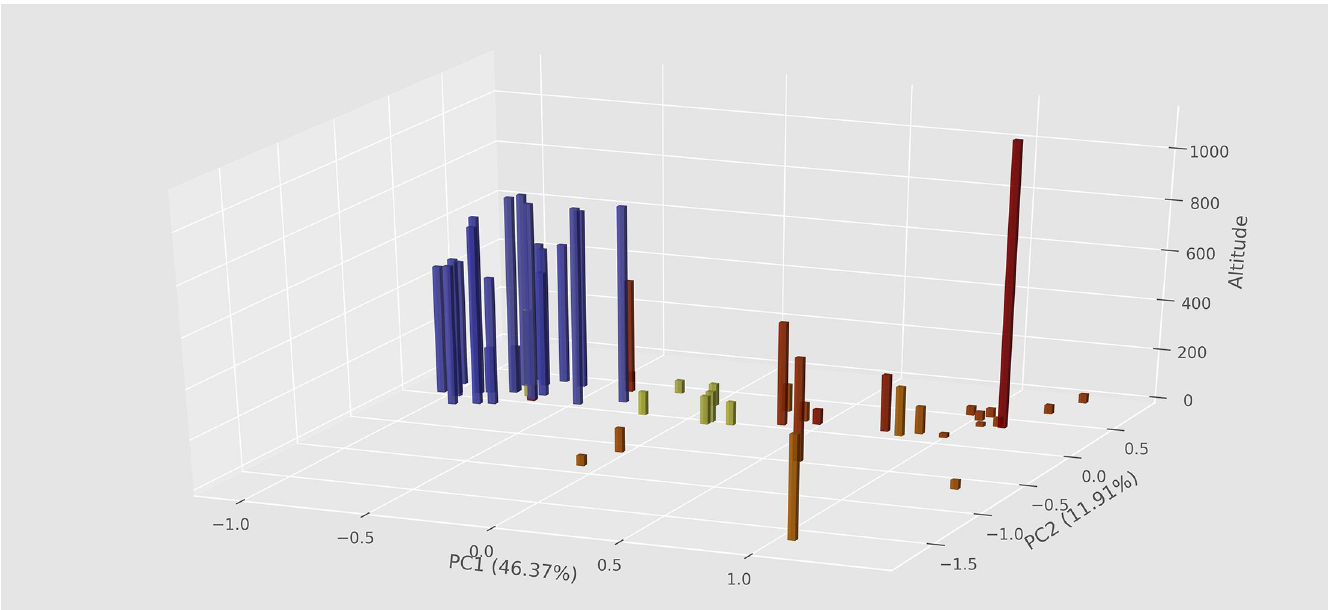
Fig 7. PCA of 27 RGB values (= 81 variables) extracted from all available females (51 specimens) of C . metamorphus sp. nov., plotted against altitude (size of bars) and latitude (color of bars, from blue on southeast to red on